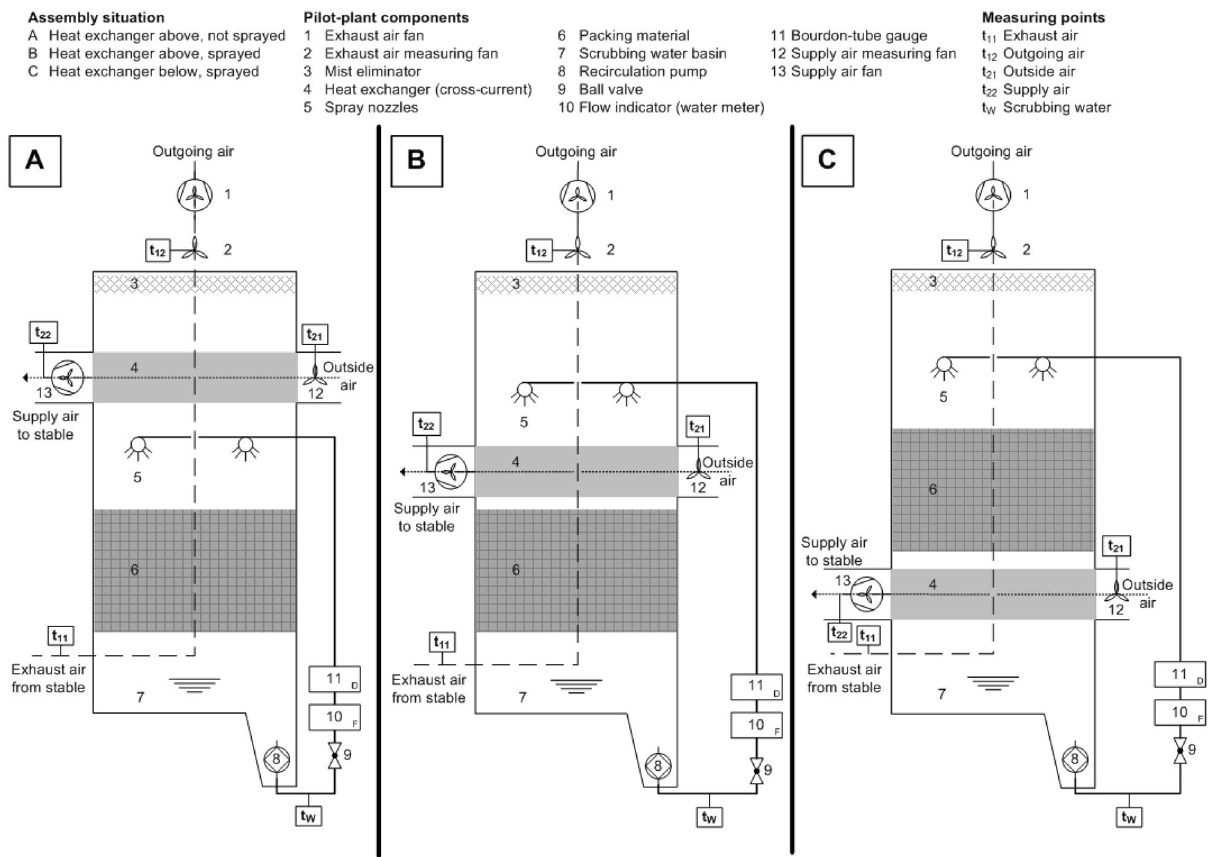
Figure 1. Schematic sketch of the exchange scrubber with the three tested assembly situations of the heat exchanger unit.